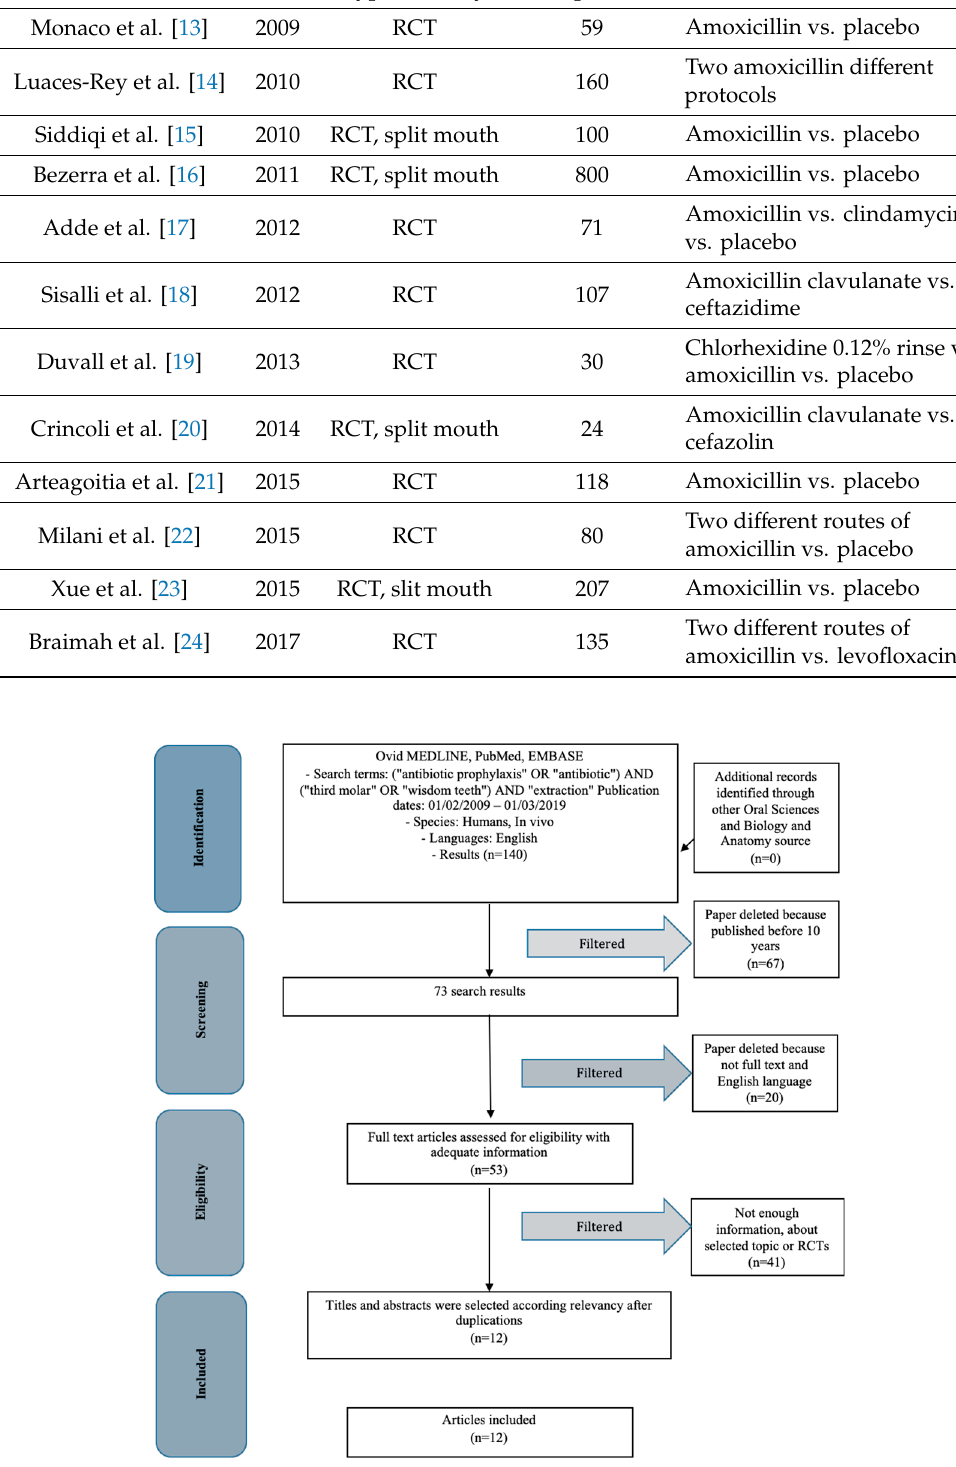
Figure 1. PRISMA (Preferred Reporting Items for Systematic Reviews and Meta- Analyses) flow diagram. RCT: randomized controlled trial.